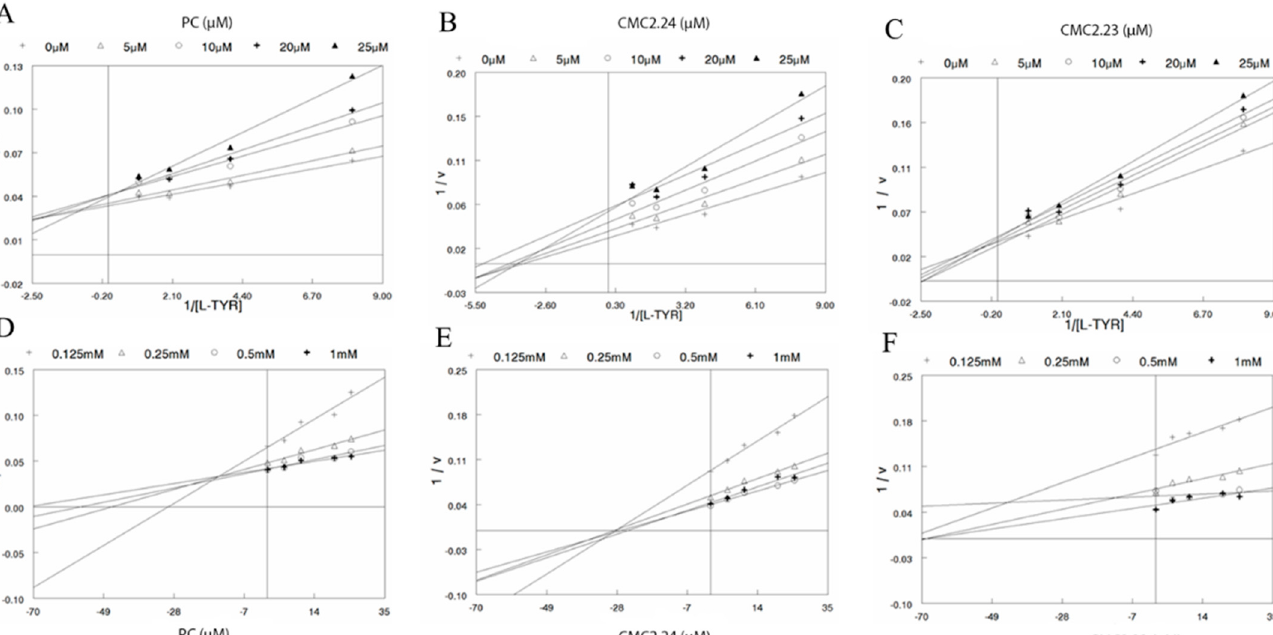
Figure 2. Kinetic analysis of monophenolase inhibition by PC, CMC2.24 and CMC2.23 ; Lineweaver-Burk plots showing the reciprocal of velocity (1/v) of tyrosinase reaction vs. reciprocal of substrate (1/ L -TYR) for ( A ) PC; ( B ) CMC2.24 and; ( C ) CMC2.23; Dixon plots for the inhibition of monophenolase activity of mushroom tyrosinase by ( D ) PC ; ( E ) CMC2.24 and; ( F ) CMC2.23 in the presence of different concentrations of L -TYR substrate (0.125, 0.25, 0.5 and 1 mM).